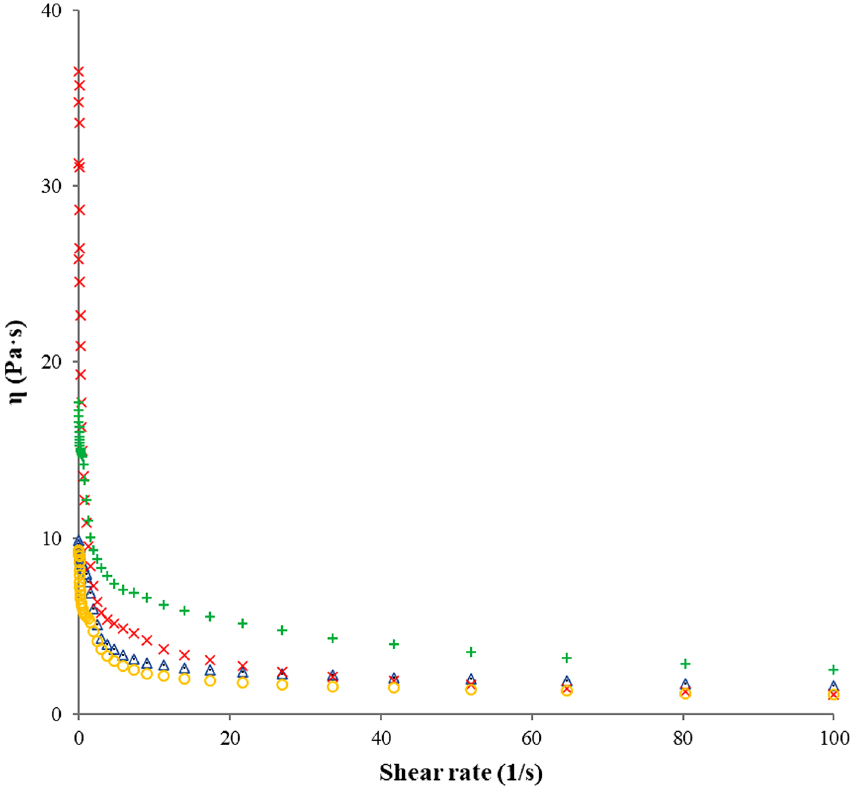
Figure 5. Flow curves of pectin solutions: Fetească Neagră pectin ( ○ ), Rară Neagră pectin ( + ), commercial apple pectin (Δ) and commercial citrus pectin ( × ); η —dynamic viscosity, ˙ γ —shear